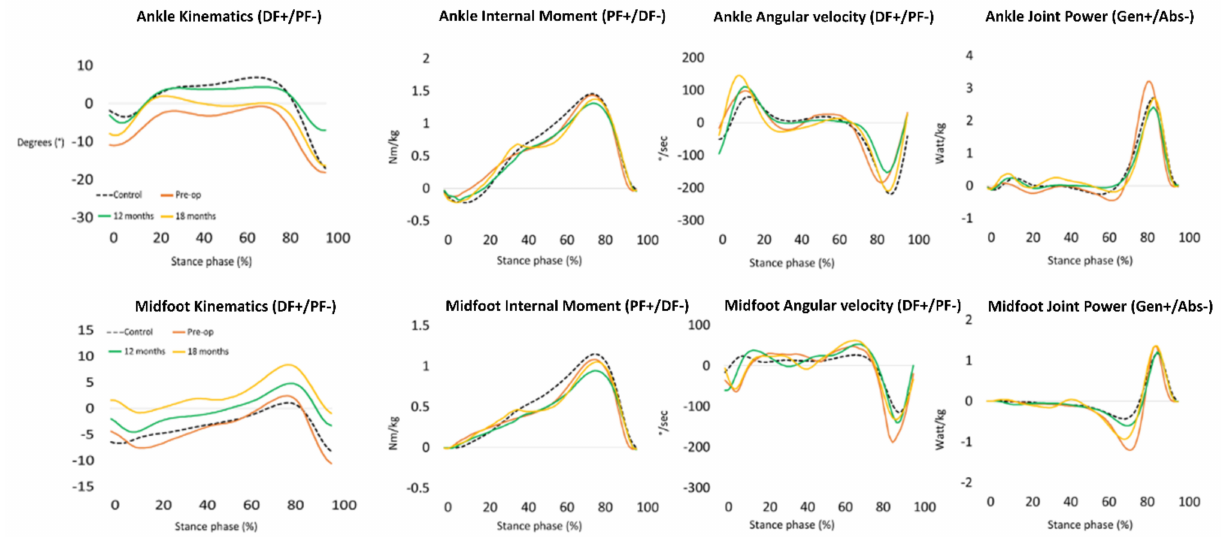
Figure 3. Kinematic and kinetic waveforms at pre-operative (orange line), 12 months (green line) and 18 months (yellow line) follow-up of the ankle and midfoot during stance phase of walking (X-axis). Normative values are visualized with a dashed black